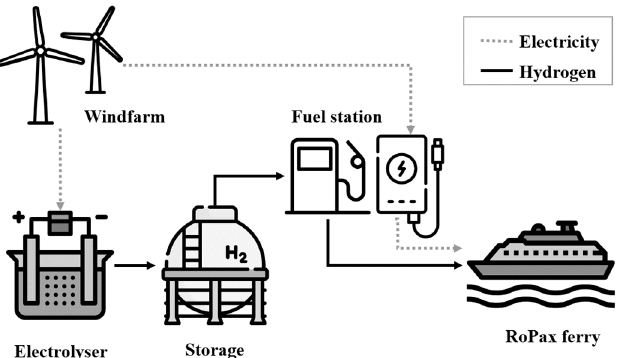
Figure 1. Marine hydrogen fuel system (Source: Created by author using Flaticon.com (accessed on 31 March 2021)).